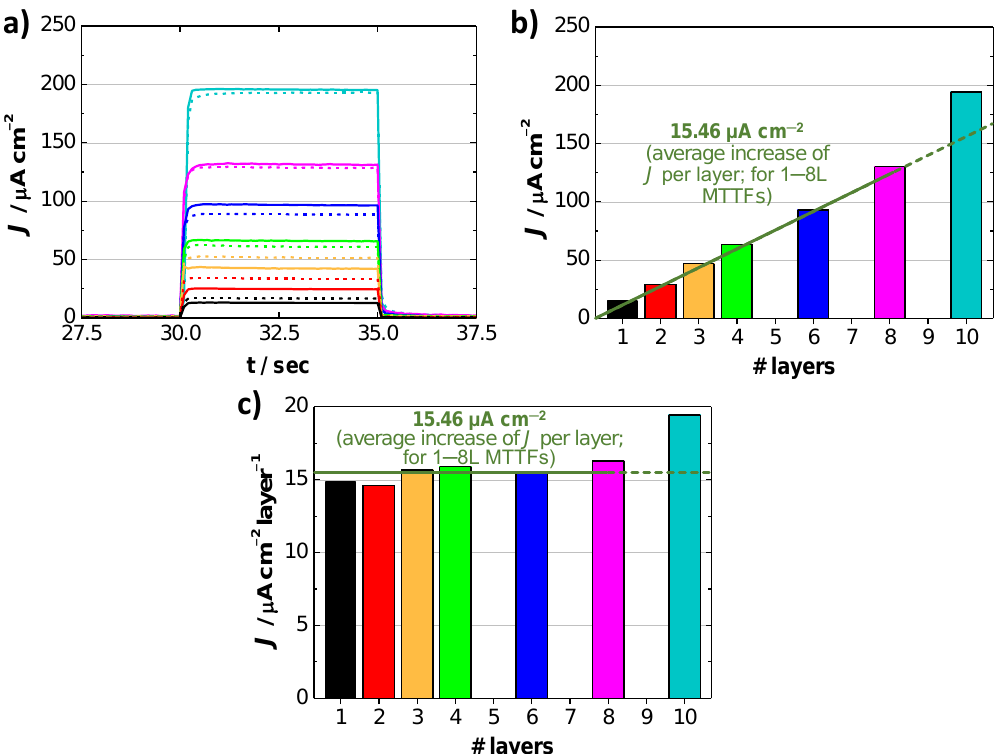
Figure 10. Photocurrent densities (during PEC water oxidation) of multi-layered MTTFs calcined at 550 ◦ C as a function of the number of deposited MTTF layers. ( a ) The corresponding chronoamperometric measurements. ( b ) Average values of the two sets of samples used during the chronoamperometric experiment. A green line indicates the average activity increase for the first eight layers. ( c ) derivative representation of ( b ) to emphasize the specialty of both 10L